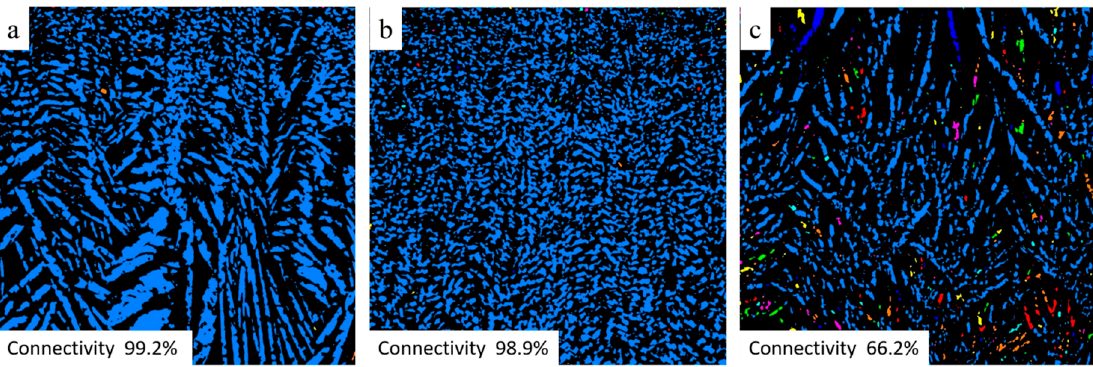
Figure 4. Micro-computed tomographic (µCT) horizontal cross-sections obtained perpendicular to freezing direction in freeze cast samples with different initial solid content (40 wt%, 50 wt%, and 60 wt%) frozen at 2 and 6 K/min (the scale bar is 1000 µm). Membranes 2020 , 10 , x FOR PEER REVIEW